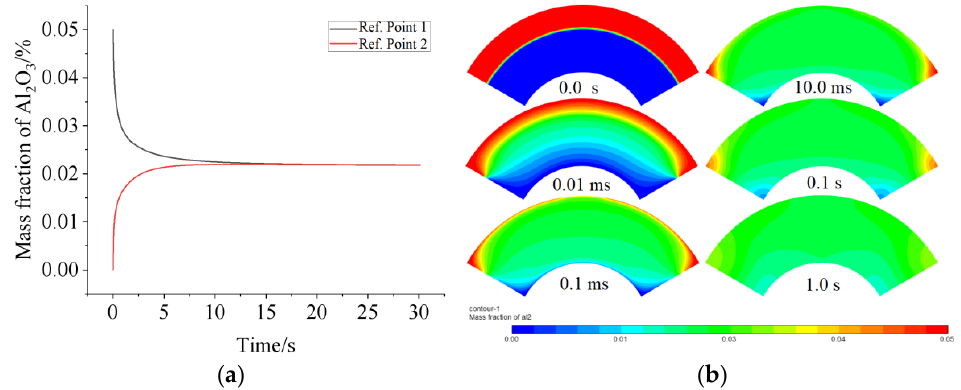
Figure 2. The mass fraction of reference point 1 and point 2 ( a ), and the diffusion process is evaluated by the concentration of nanoparticles at various times. The initial mass fraction of Al 2 O 3 is 5 wt% ( b ).